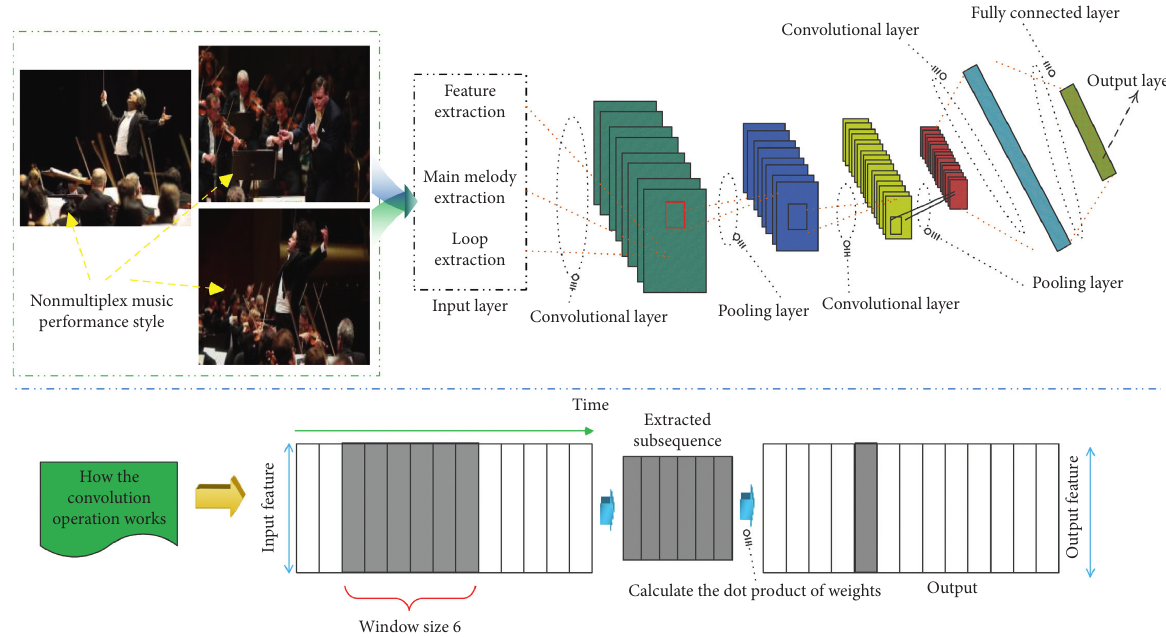
Figure 2: Convolutional neural network working mode.